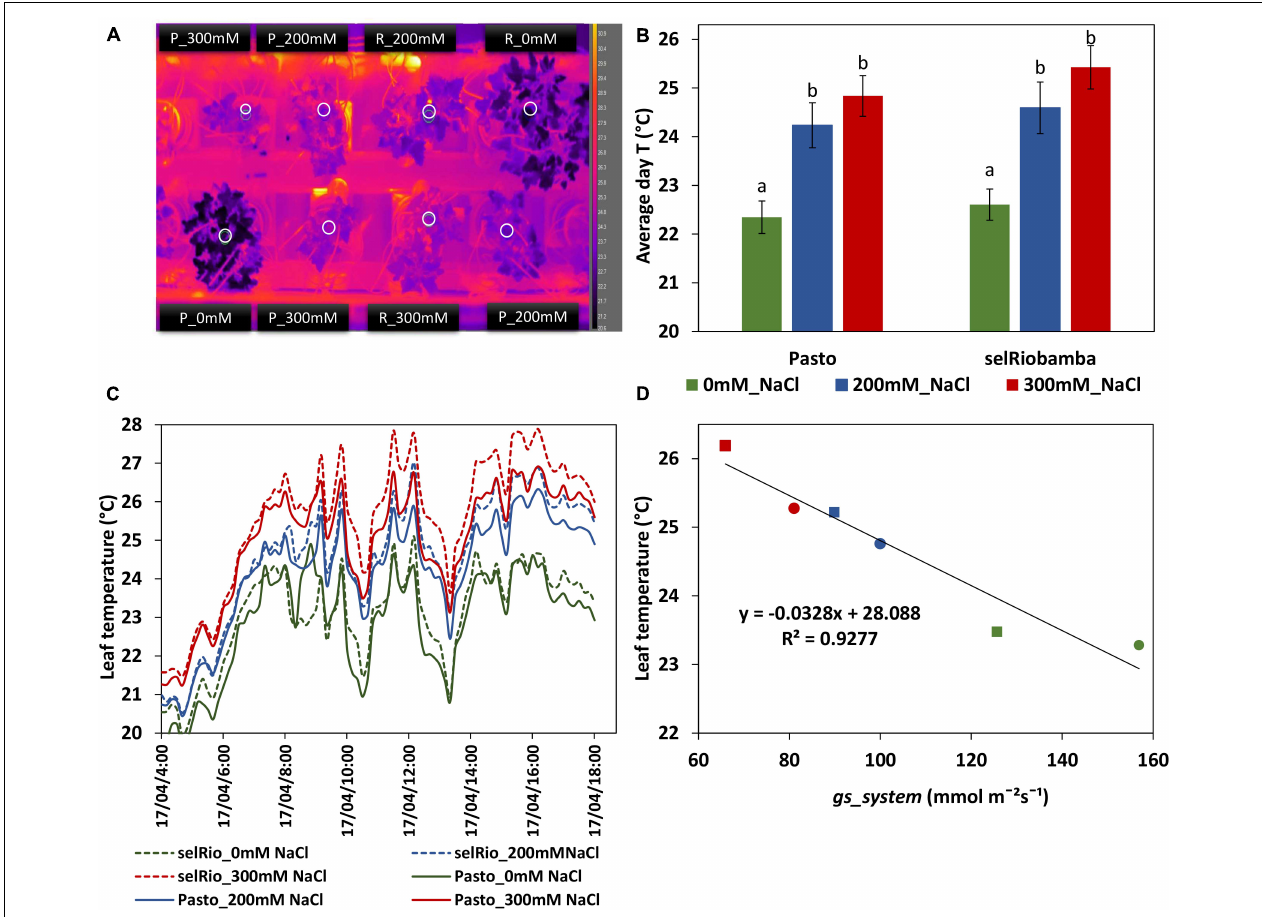
FIGURE 5 | Leaf temperatures from thermal imaging for quinoa. (A) Thermal image obtained by a FLIR A655SC Thermal Camera. White circles indicate the regions used to determine the mean leaf temperature per plant. (B) Average leaf temperature during the day (07:00 AM–18:00 PM). Means of 7 consecutive days (59-65 DAS). Error bars indicate SE of individual means in the same plant. Statistically significant differences ( p ≤ 0.05) between any variety and salt treatment combination are shown with different letters. (C) Fluctuation of leaf temperature during a day (63 days after sowing, 42 days after start of the stress). (D) Correlation between leaf temperatures and gs_system derived from Plantarray